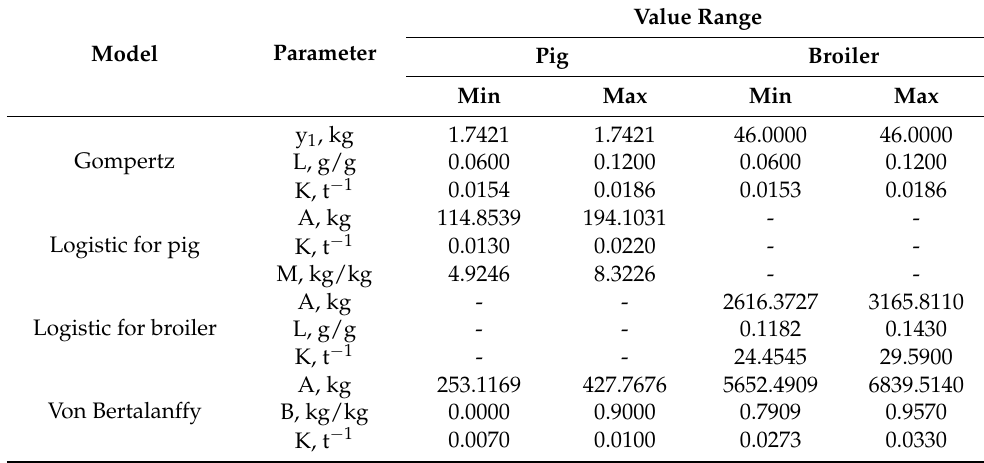
Table 2. Database of broilers’ historical growth, age, and